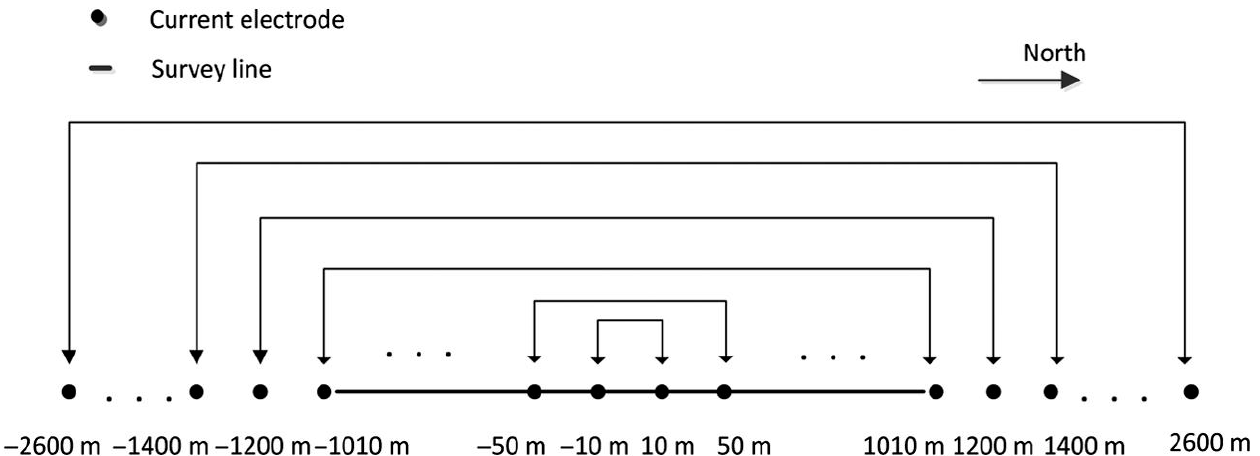
Figure 33. Nonconventional gradient array protocol for the survey line. Current was supplied by using 34 current electrode groups with a maximum current electrode spacing of 5200 m, and a minimum spacing of 20 m. The spacing between the potential electrodes is 20 m (modified from [105]). There are various electromagnetic interferences in the measured waveforms. Consid- ering the short-term and random nature of electromagnetic interferences, robust super- position and correlation detection are used to enhance the signal-to-noise ratio